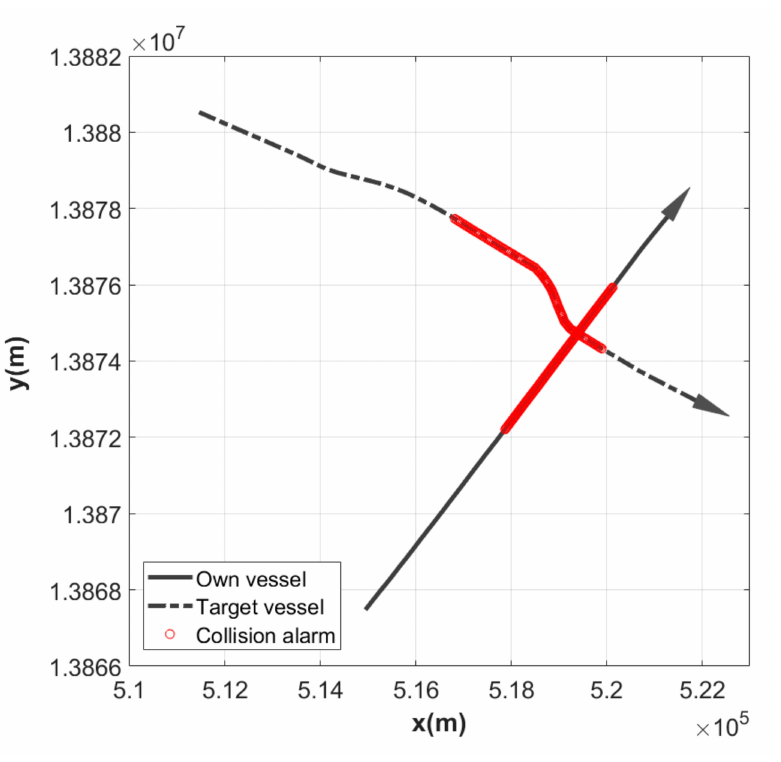
Figure 4. Trajectories of encountering vessels in the case of crossing situation.